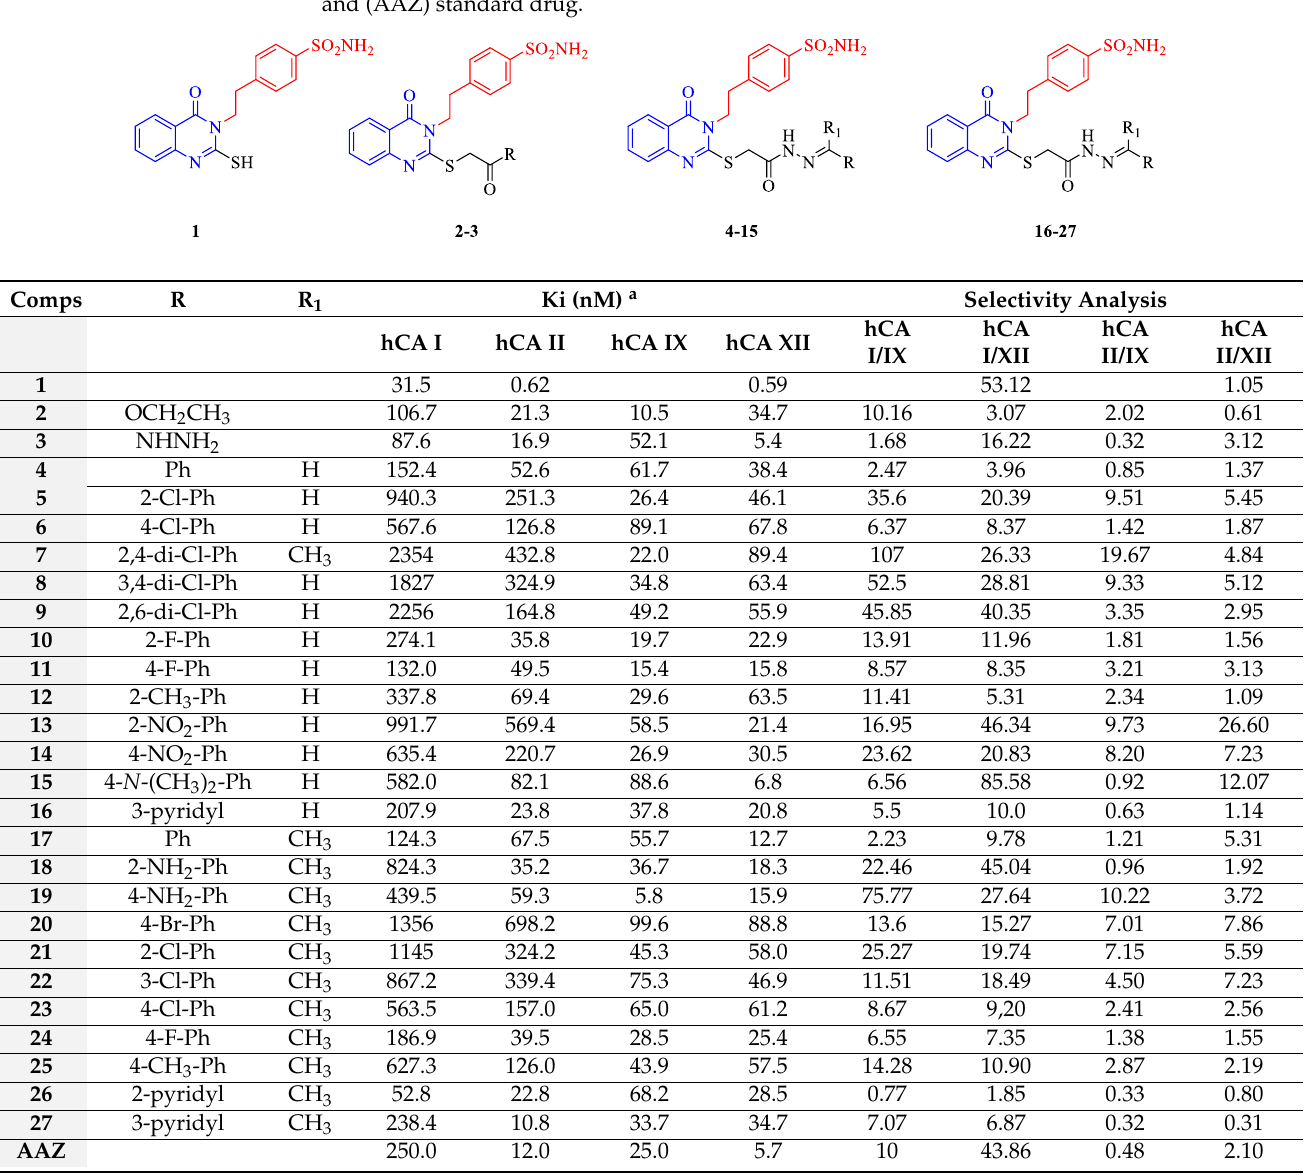
Table 1. Inhibition data of human CA isoforms hCA I, II, IX, and XII for hydrazonoquinazolines 2 – 27 and (AAZ) standard drug.